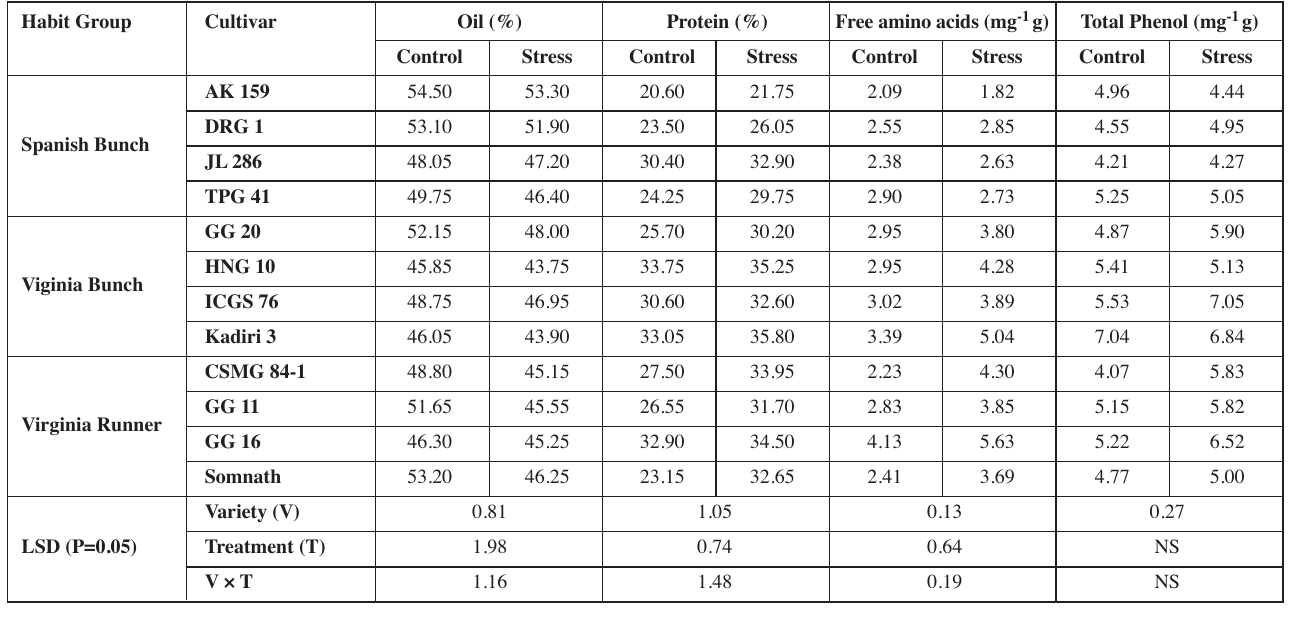
Tab. 4: Effect of water deficit stress on oil, protein, free amino acids and total phenol content of groundnut kernels